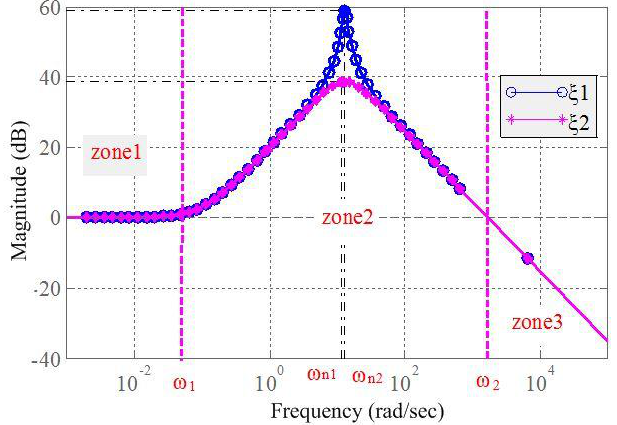
Figure 8. Bode diagram of the cab mount system (ξ2 < ξ1).